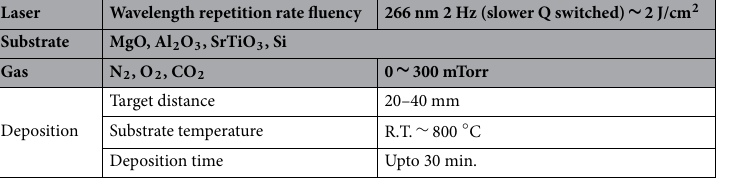
Table 1. Conditions for carbon film deposition by PLD. Variety of materials were used as targets in nitrogen, oxygen and carbon dioxide atmosphere with varied distance to the target. *Slower Q switched YAG 9 .